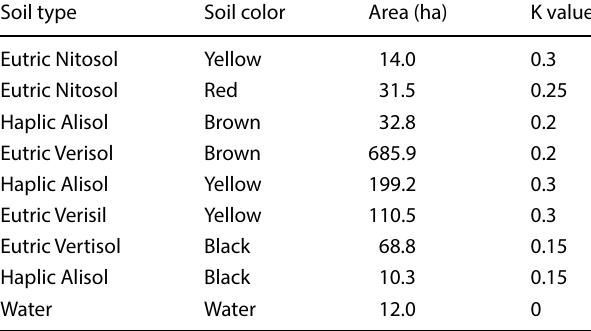
Table 4 Soil types, colors, and K-factor